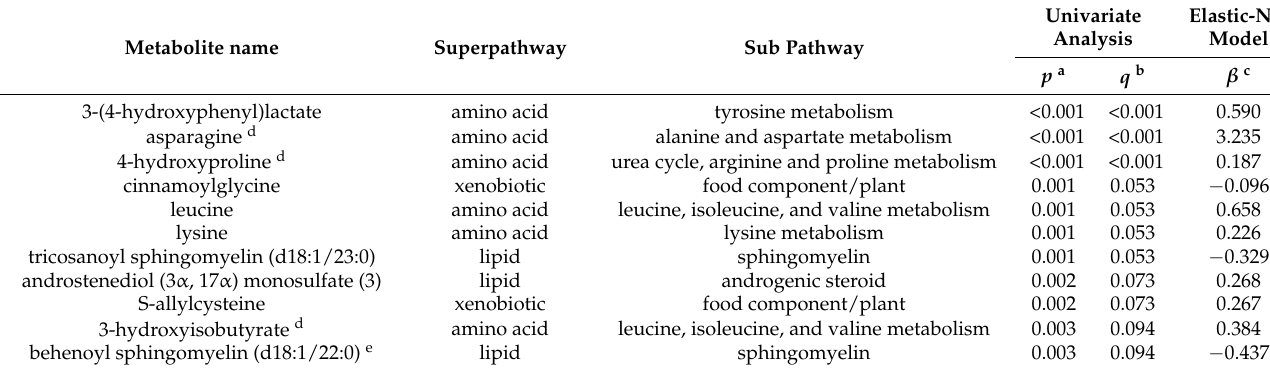
Table 3. Selected markers of short-term red meat consumption.